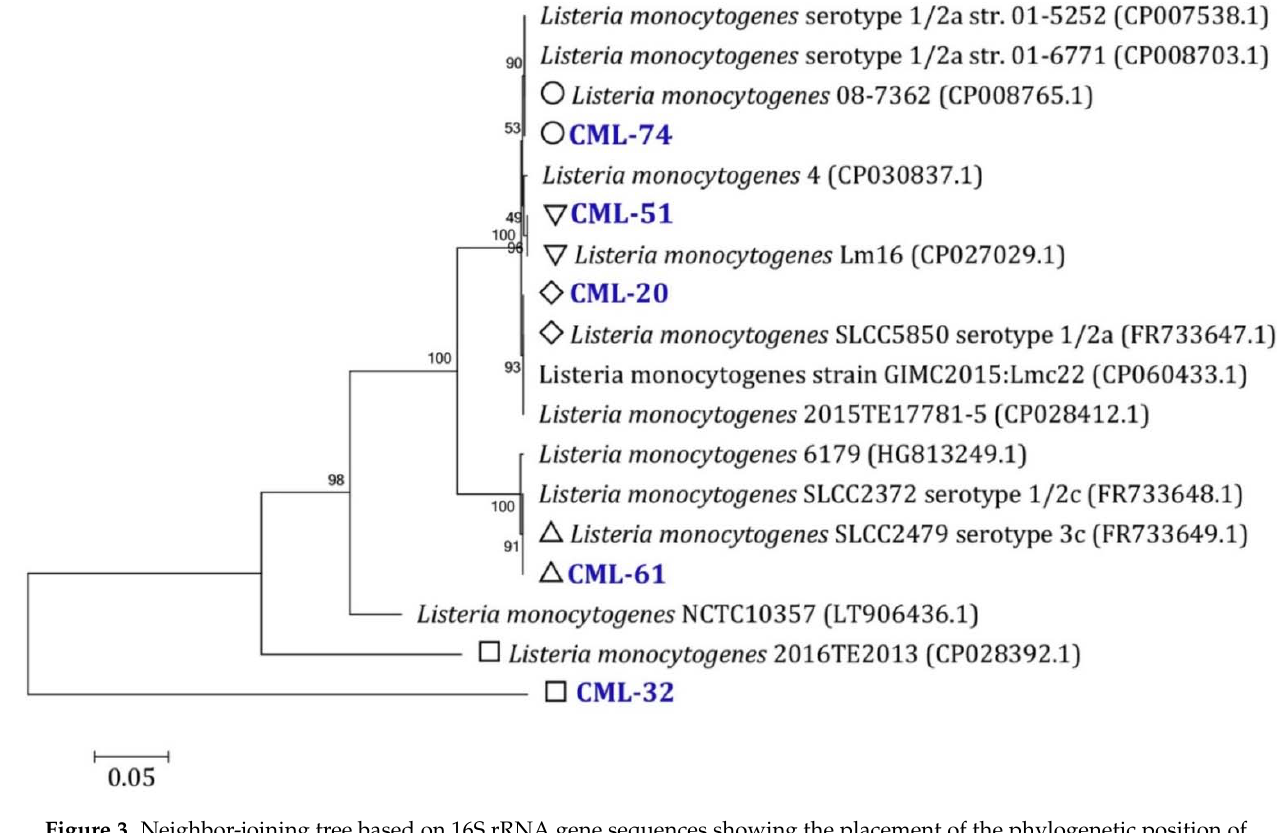
Figure 3. Neighbor-joining tree based on 16S rRNA gene sequences showing the placement of the phylogenetic position of the selected L. monocytogenes strains within closely related taxa. Bootstrap value ( ≥ 50%) derived from 1000 replicates.